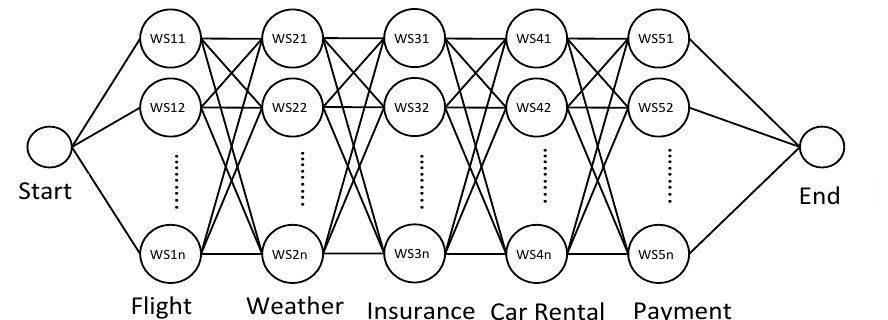
Figure 2. An example of travel Agency web service and candidate web services for each task.